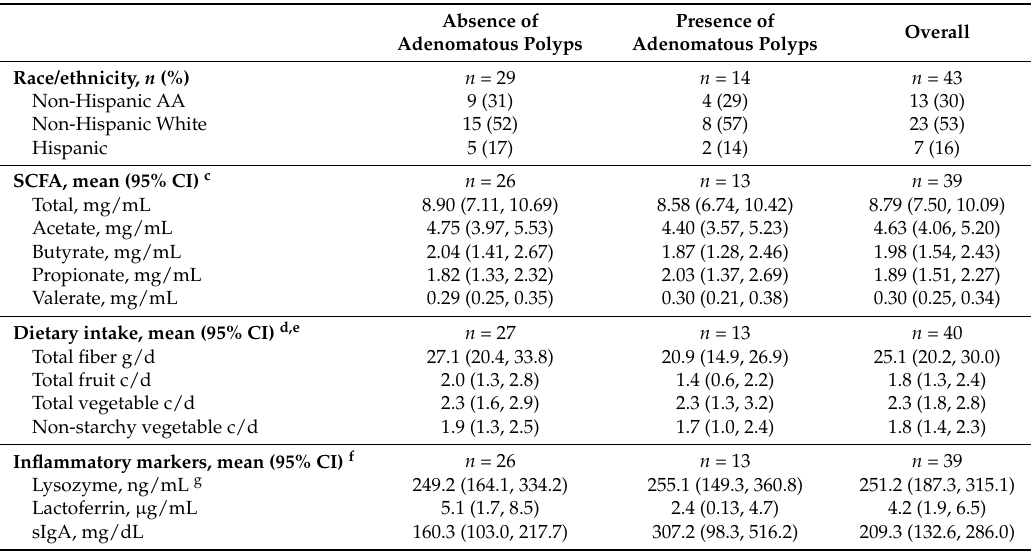
Table 3. Comparison of participants with adenomatous polyps to those without, among participants who completed colonoscopy a,b .